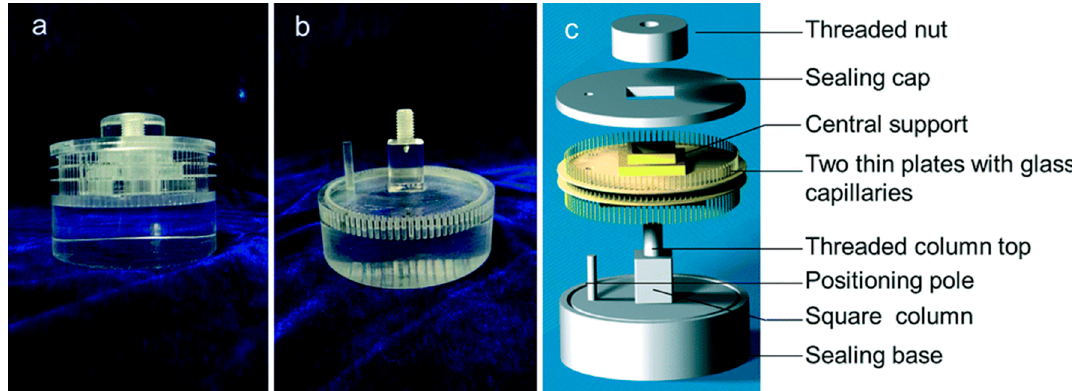
Figure 13. Schematic diagram of the high-throughput crystallization screening setup [26]. ( a ) The high-throughput crystallization setup using in the magnet; ( b ) the reservoir base; ( c ) the structure details of the high-throughput crystallization setup. Reproduced from reference [26] with permission from the PCCP owner societies.